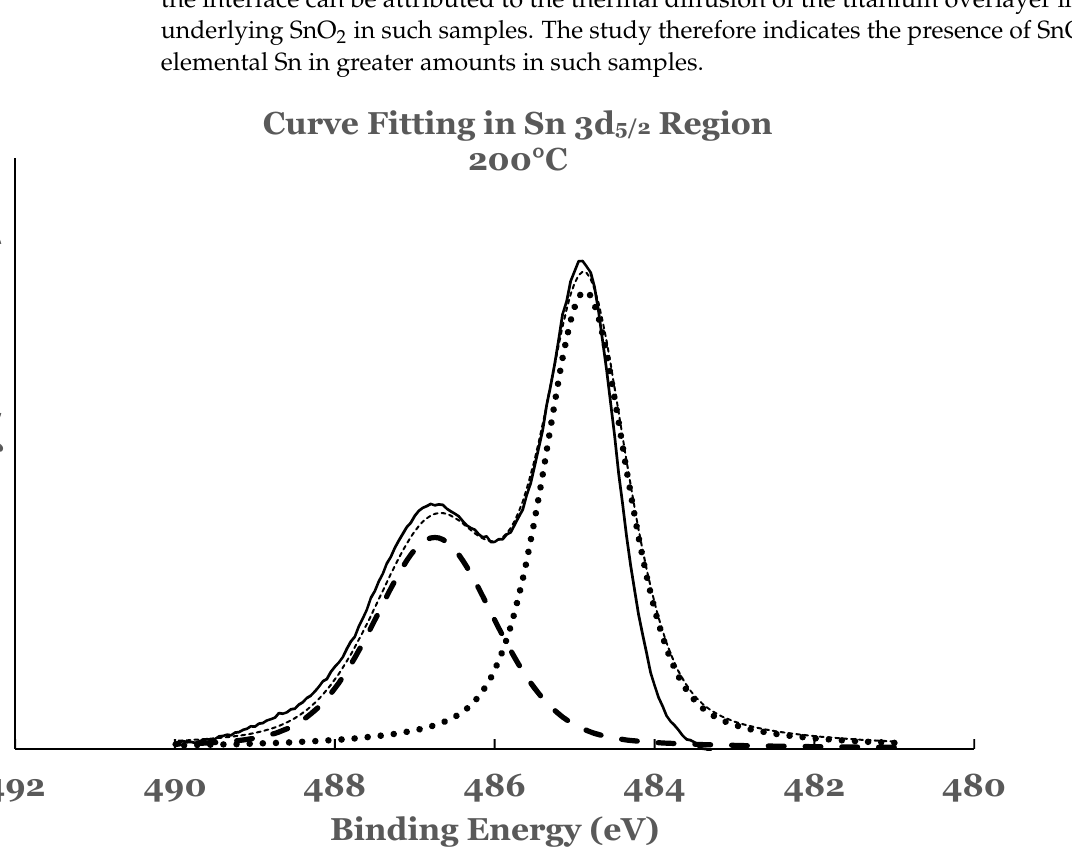
Figure 8. Curve fit for the 3d 5/2 region of tin for the 1.1 nm titanium overlayer deposited at substrate temperature of 200 °C. The thin solid line represents the experimental data. The thick dotted line represents the spectrum from elemental Sn while the thick dashed line that from SnO 2 . The thin dotted line represents the superposition from elemental Sn and SnO 2 .